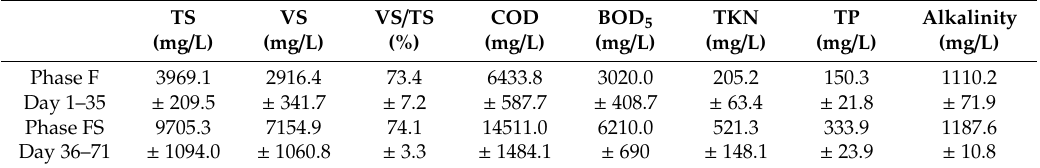
Table 2. Characteristics of the input in the di ff erent phases of the tests (average and standard deviation).